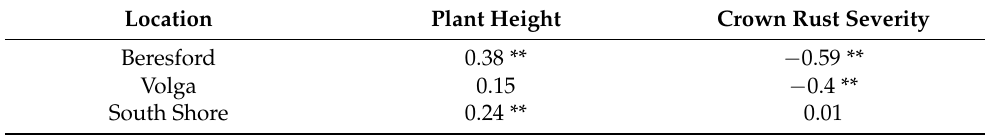
Table 3. Pearson correlation coefficient ( r ) of dry biomass with plant height and crown rust severity.